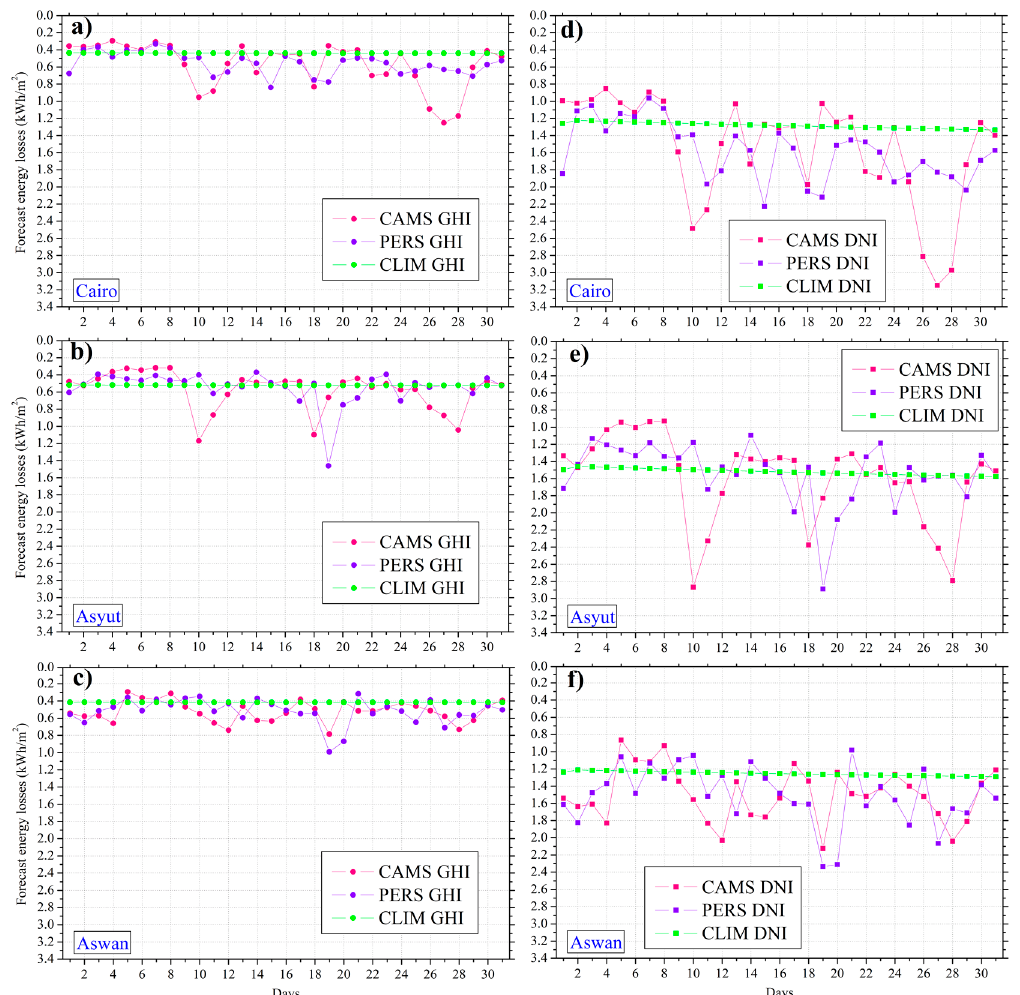
Figure 8. Daily mean forecast solar energy losses in kWh/m 2 for the regions of CAI ( a , d ), ASY ( b , e ) and ASW ( c , f ). The AOD forecasting techniques of CAMS, MODIS PERS and MODIS CLIM were applied as inputs to the SENSE producing the solar energy potential in terms of GHI ( a , b , c ) and DNI ( d , e , f ).